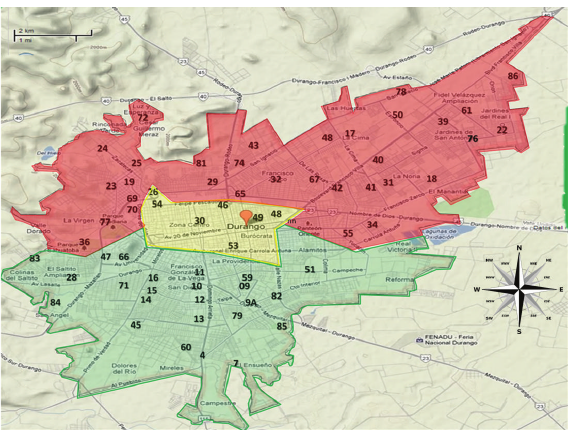
Figure 2: Location of wells in the city, which are distributed by geographic region (north, south, and central). Figure 3: Fluoride concentration distribution in the city of Durango